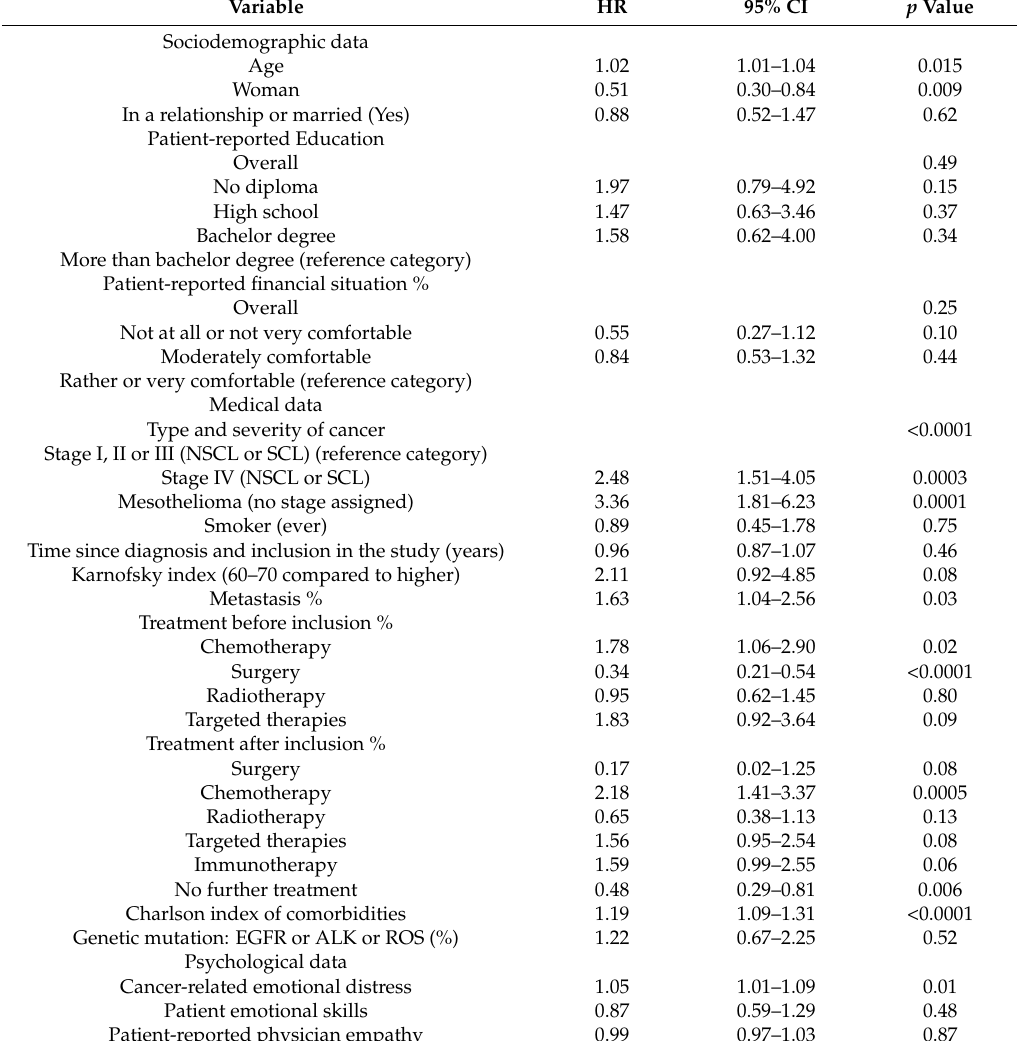
Table 2. Unadjusted Cox Proportional Hazard Ratios for overall